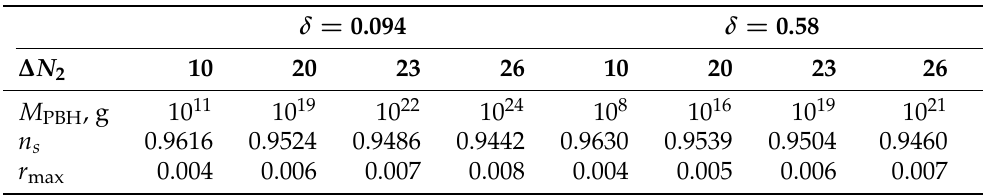
Figure 8. The power spectrum at δ = 0.1 on the plot ( a ) and at δ = 0.6 on the plot ( b ) near the pivot scale k ∗ = k ∆ N changing ∆ N 2 , respectively. Table 4. The PBH masses estimated by Equation (57) for δ = 0.094 and δ = 0.58, with the correspond- ing values of n s and r max .